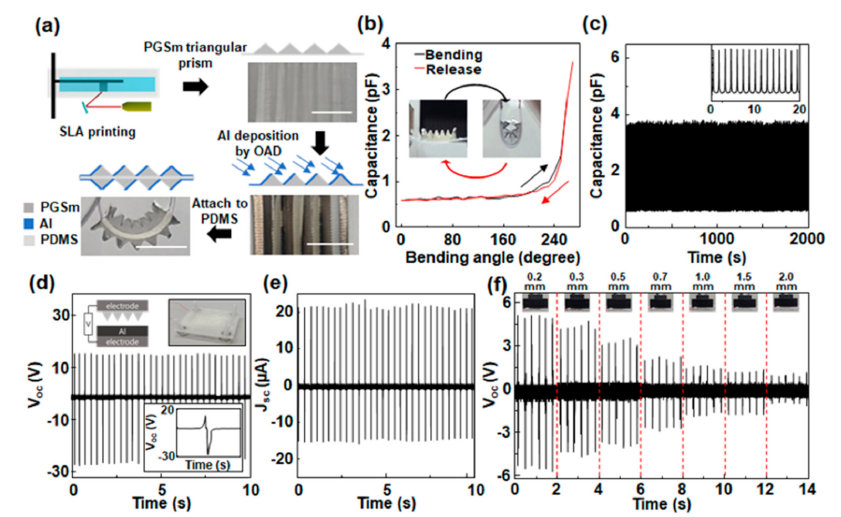
Figure 1. ( a ) The schematic diagram for the fabrication of triboelectric-type bending sensor. Scale bar: 1 cm. ( b ) Capacitance change of triboelectric-type bending sensor and ( c ) stability test. ( d ) Out-put open-circuit voltage and ( e ) short-circuit current of PGSm/Al TENG. ( f ) Output voltages of PGSm/Al TENG with various gap distance from 0.2 mm to 2.0